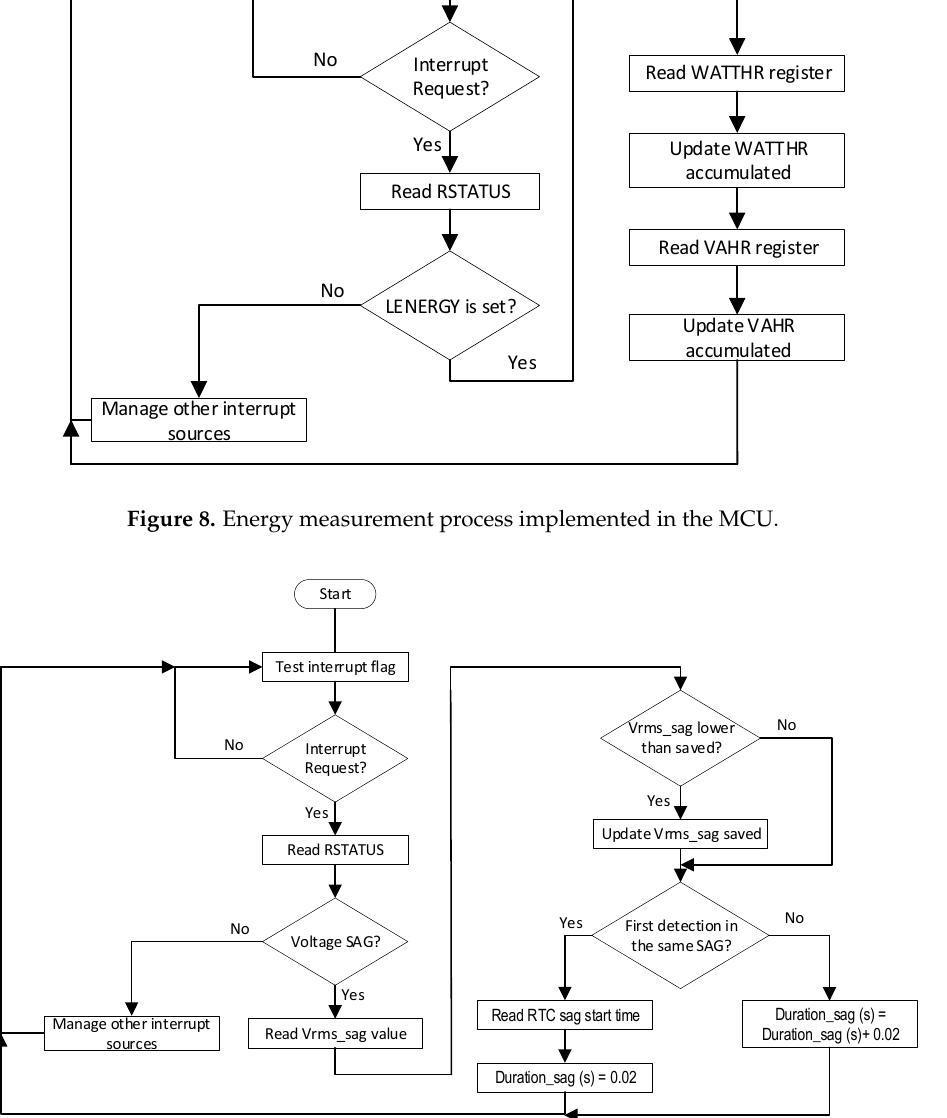
Figure 8. Energy measurement process implemented in the MCU.